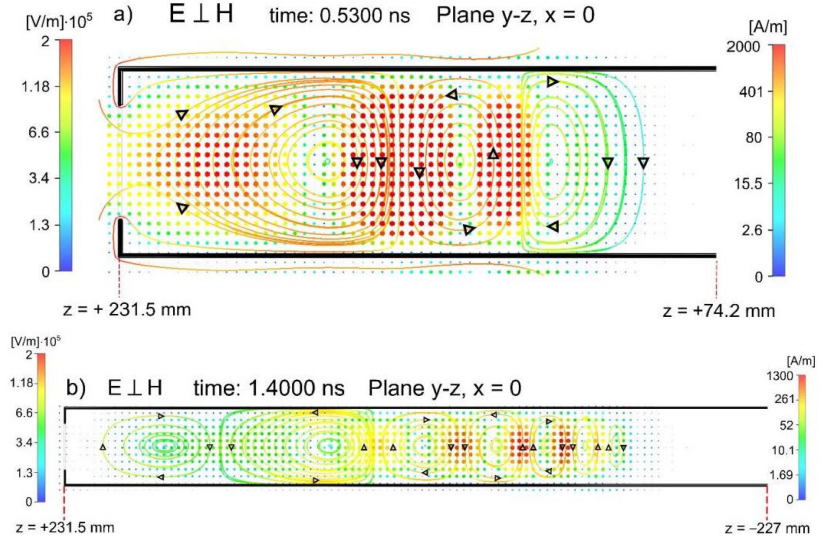
Figure 8. Associated electric (E1) and magnetic (H1) field structures at t = 0.1779 ns. ( a ) in the plane x-z (y = 0): the arrows show the electric field vectors, the dots show the magnetic field vectors which are perpendicular to plane y = 0 (facing away from the observer); color bar was not used to display the amplitudes, ( b ) in the plane y-z (x = 0): the dots show the electric field vectors (in logarithmic scale) which are perpendicular to plane y = 0 (directed to the observer); the isolines illustrate the fringing of magnetic field lines (in logarithmic scale) through the aperture into the enclosure. Retrieved from Figure 5Eb,Hb.